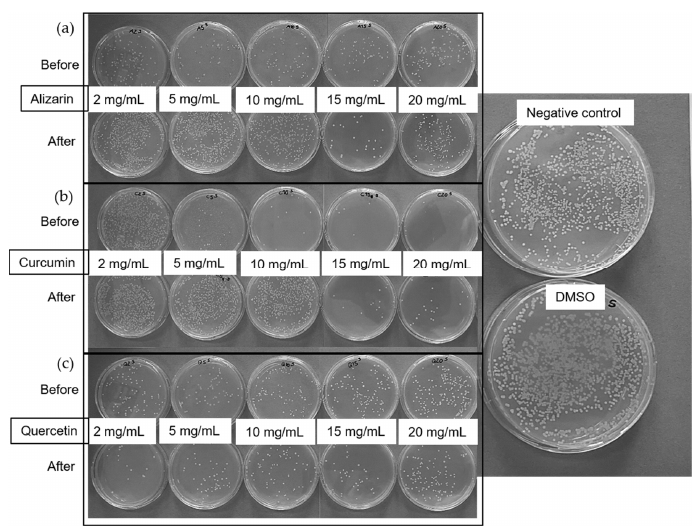
Figure 7. Antibacterial activity testing of ( a ) alizarin, ( b ) curcumin, and ( c ) quercetin against S. au- reus before and after thermal treatment of the dyes at 230 °C.